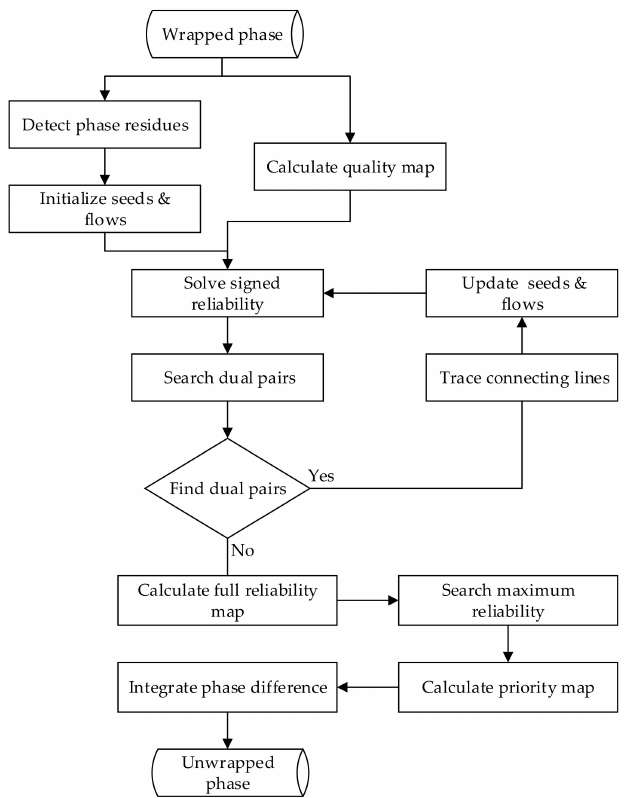
Figure 5. Processing flow chart of PU with